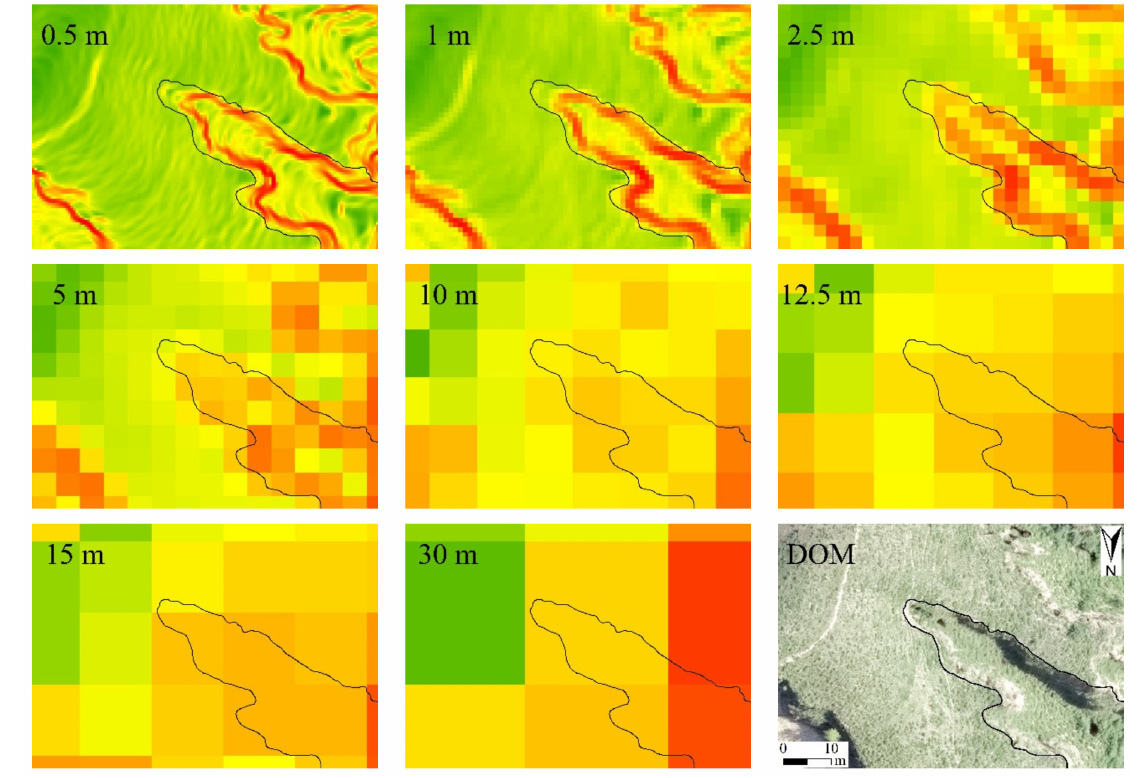
Figure 10. Slope gradient at various